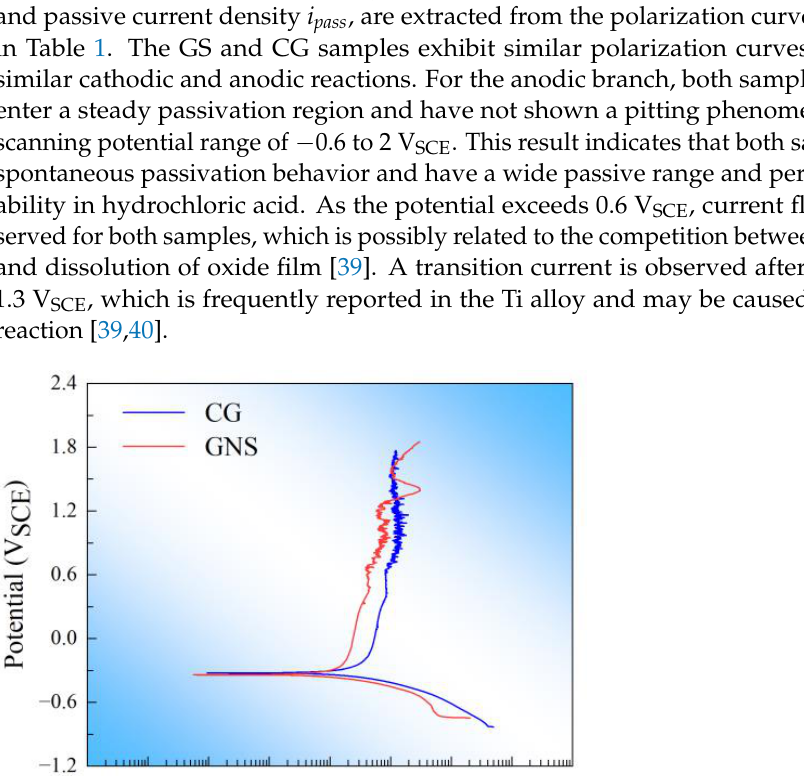
Table 1. Corrosion parameters obtained from the polarization curves.